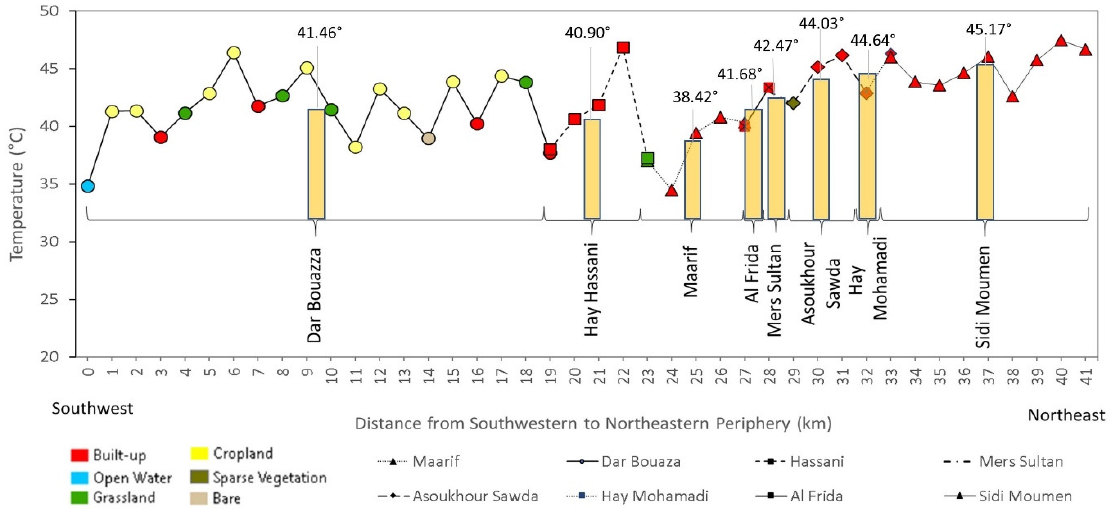
Figure 15. Southwest-northeast transect at 1-km intervals (white circles) crossing eight major communes of Casablanca.